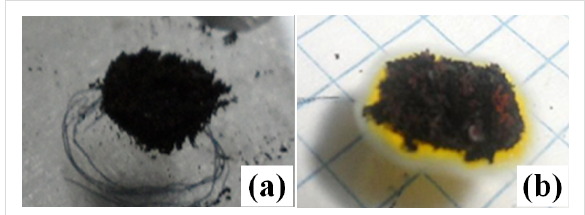
Figure 16: Sample images of MWCNT/ferrocene mixture (with weight ratio 1:3) positioned on the slide before (a) and after photo-induced ignition process